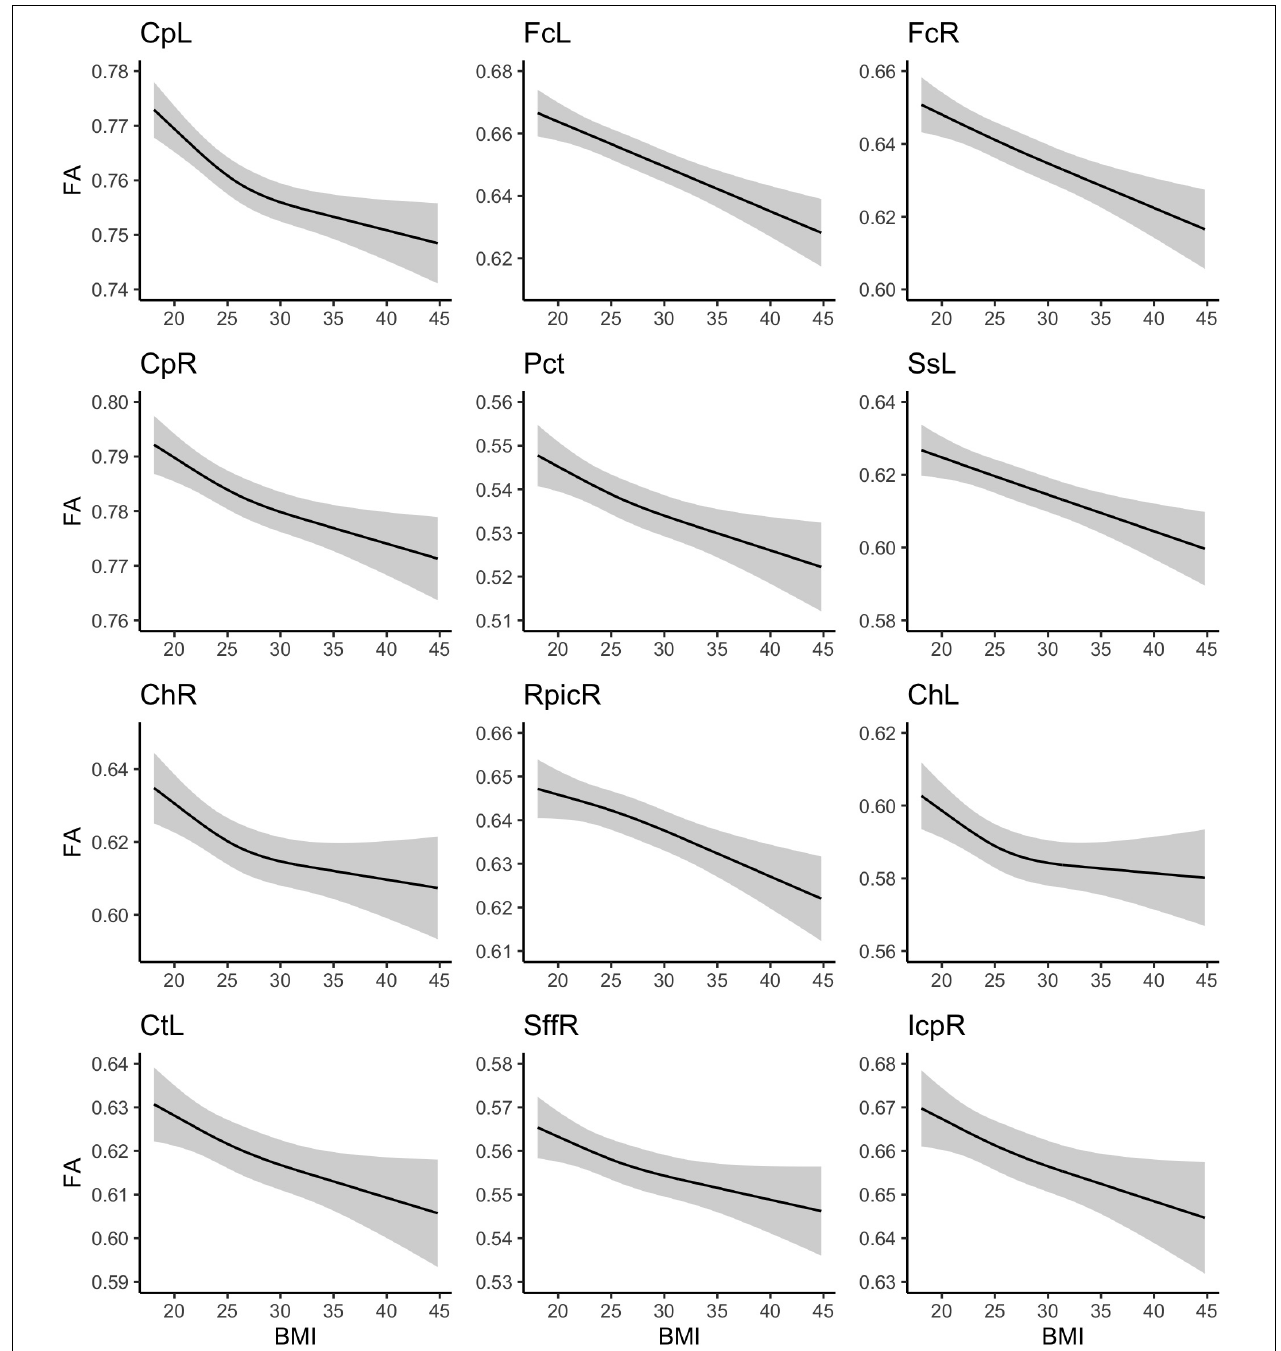
FIGURE 2 | Association between body mass index and white matter fractional anisotropy values.